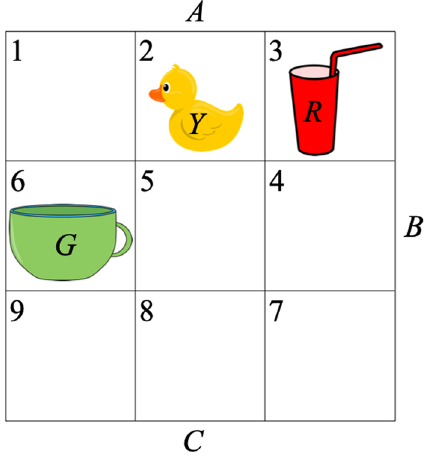
Figure 2: A numbered grid with three objects: a red glass ( R ) , a green cup ( G ) , and a yellow duck ( Y ) . The objects are placed in di ff erent initial cells of the grid. Three robots A, B, and C are placed around the tabletop, and each robot can reach only some of the